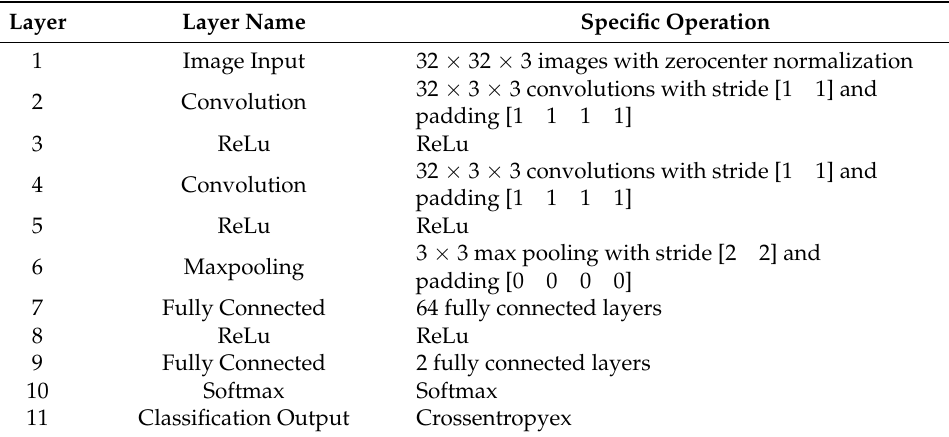
Table 1. Whole CNN Structure of Faster R-CNN Model.